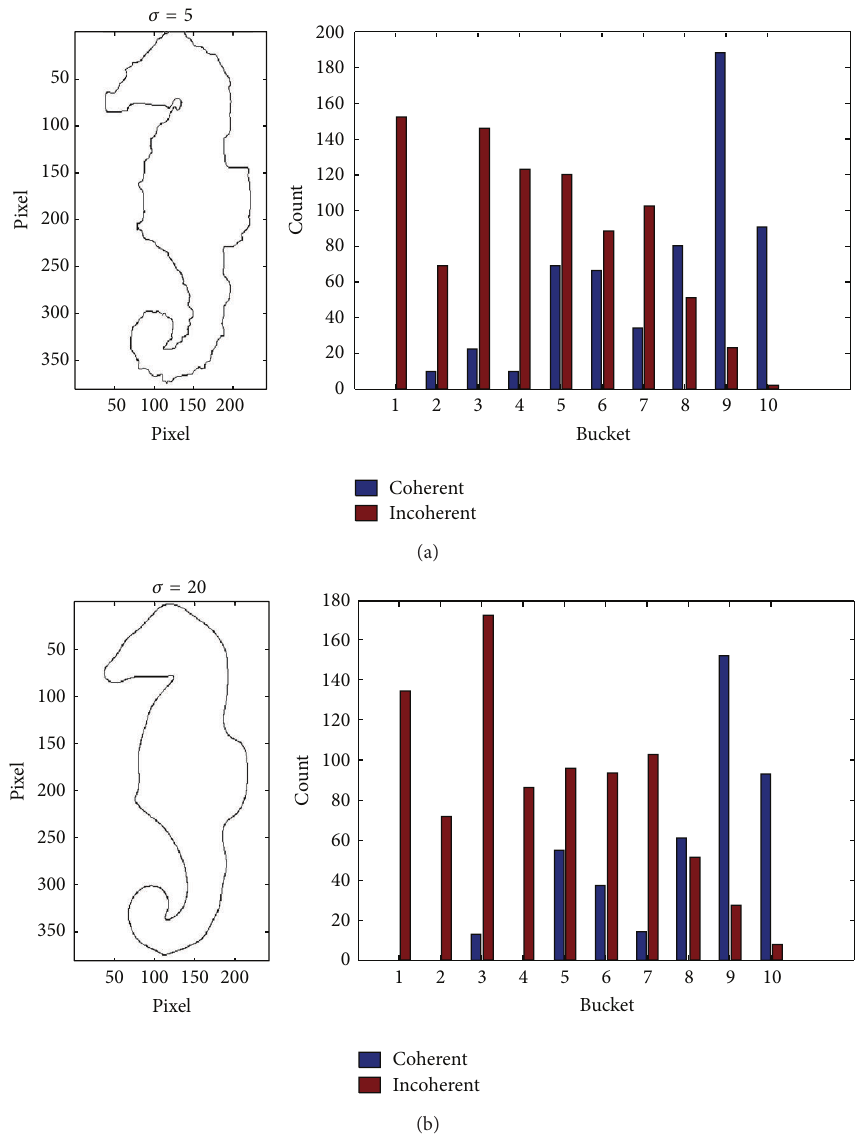
Figure 6: The evolved contour curves and their MDCV histograms with different scale factors for the image polluted by noise. (a) 𝜎 = 5 ; (b) 𝜎 = 20